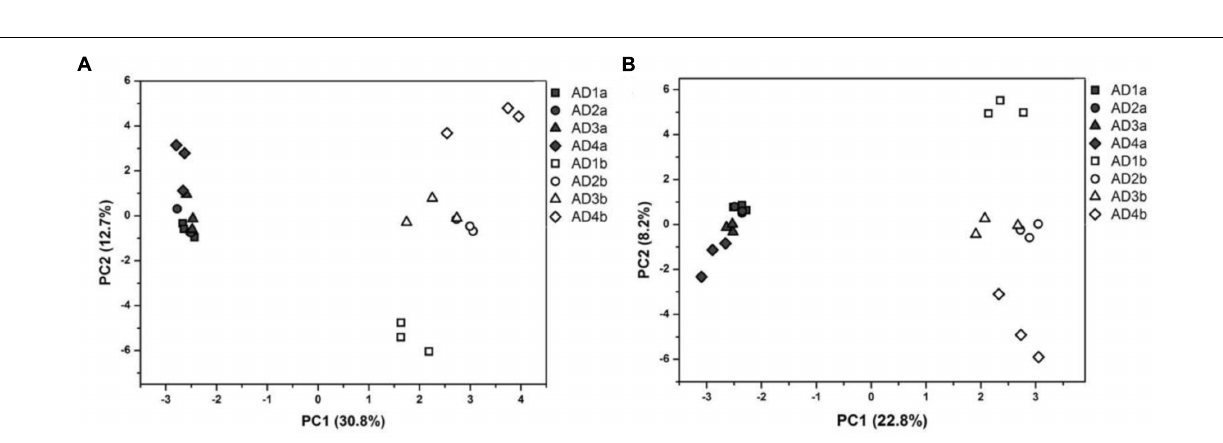
Frontiers in Microbiology |